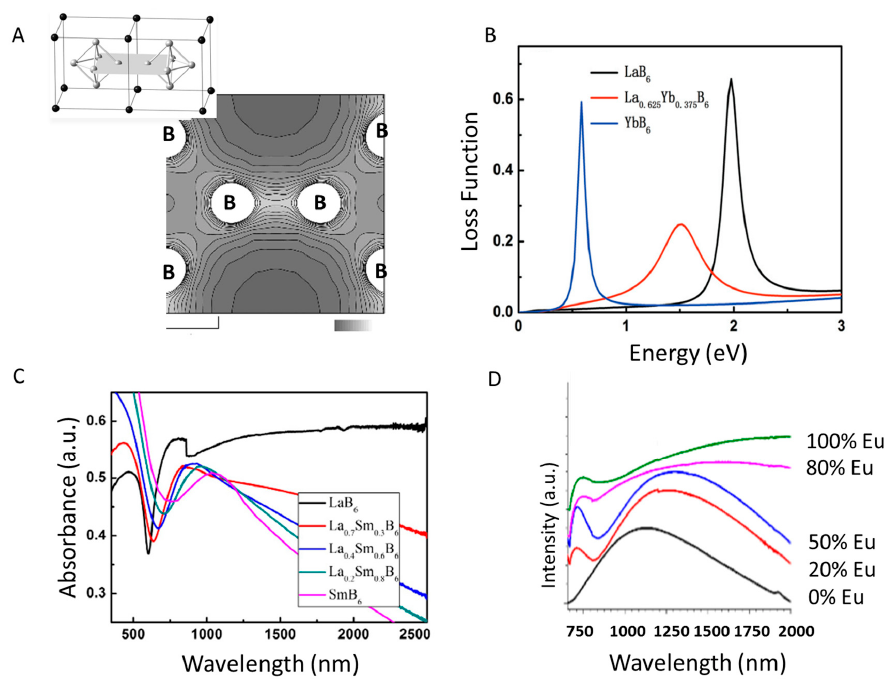
Figure 4. ( A ) Total charge density map of LaB 6 (grey scale shows increasing charge density) (reprinted from [67]). ( B ) Energy loss function of LaB 6 , La 0.625 Yb 0.375 B 6 and YbB 6 in the low energy